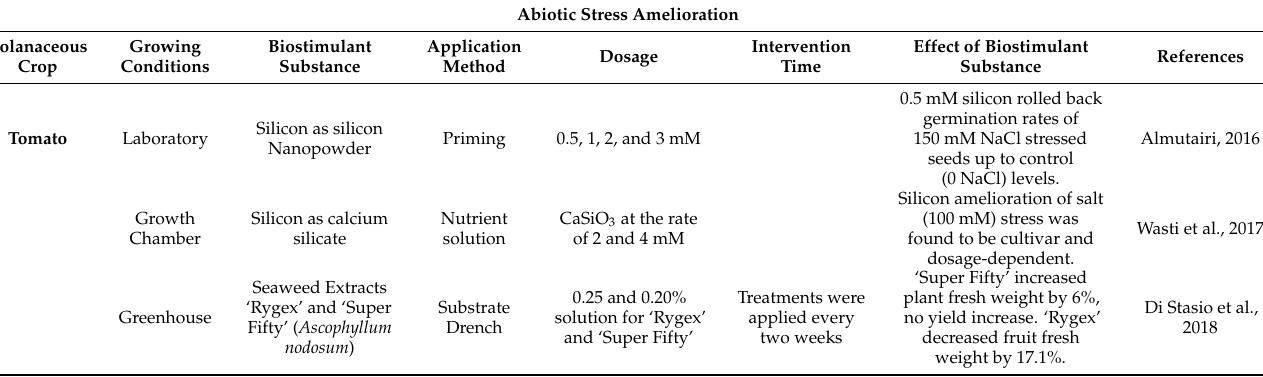
Table 3. An overview of the abiotic stress amelioration, growth improvement, and fruit quality enhancement by biostimulant substances on Solanaceous vegetable